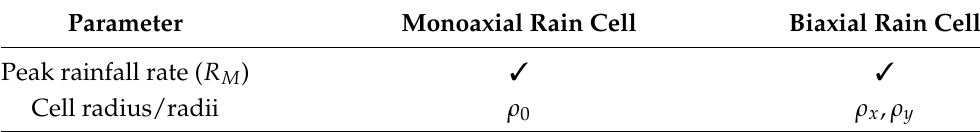
Table 6. Parameters of EXCELL